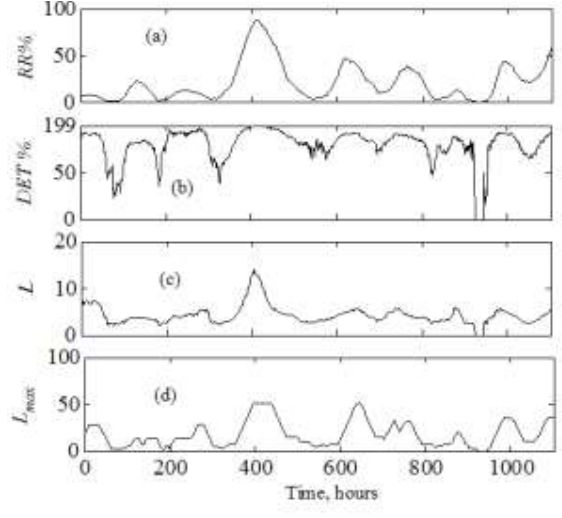
Figure 16. CRQA measures for wind speed and wind